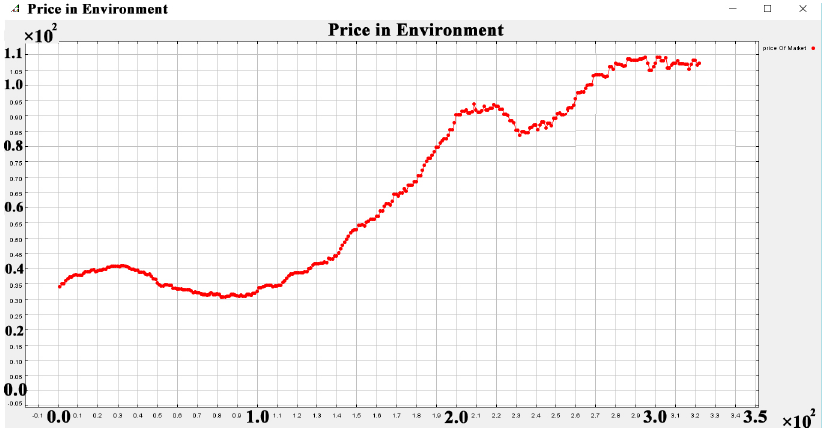
Figure 8. Market price curve – public